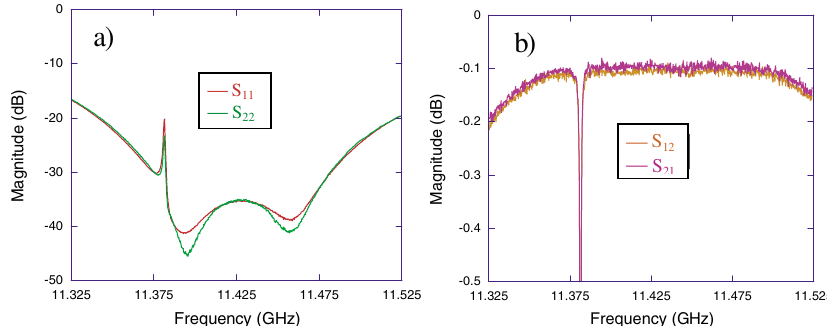
FIG. 3. (Color) Network analyzer measurements of the scattering parameters, showing (a) match and (b) transmission of two X -band TM mode converters 01